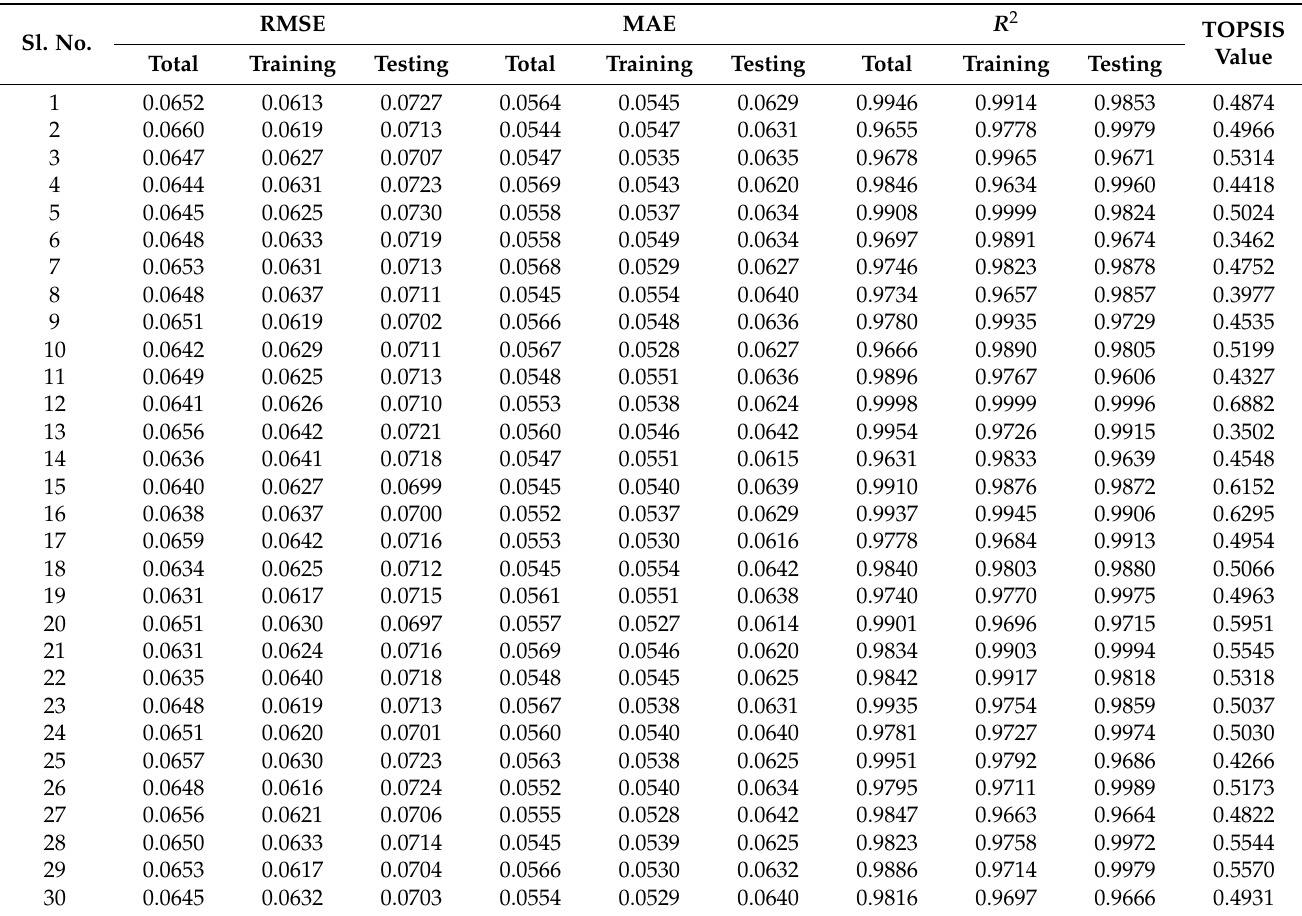
Table 6. Performance of SVR model for crack length (L) using MFO algorithm.